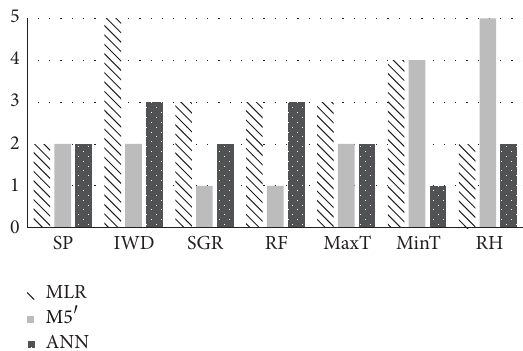
Figure 1: Quantity of occurrences of each attribute in the OAS for each technique (only crop datasets with 2007 testing data).